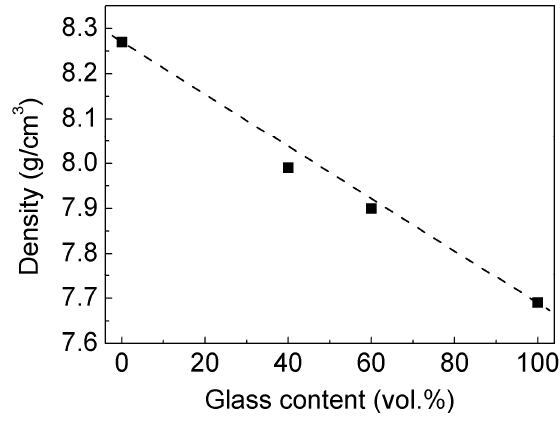
Figure 5. Densities of the consolidated blended composites as a function of the volume fraction of glass